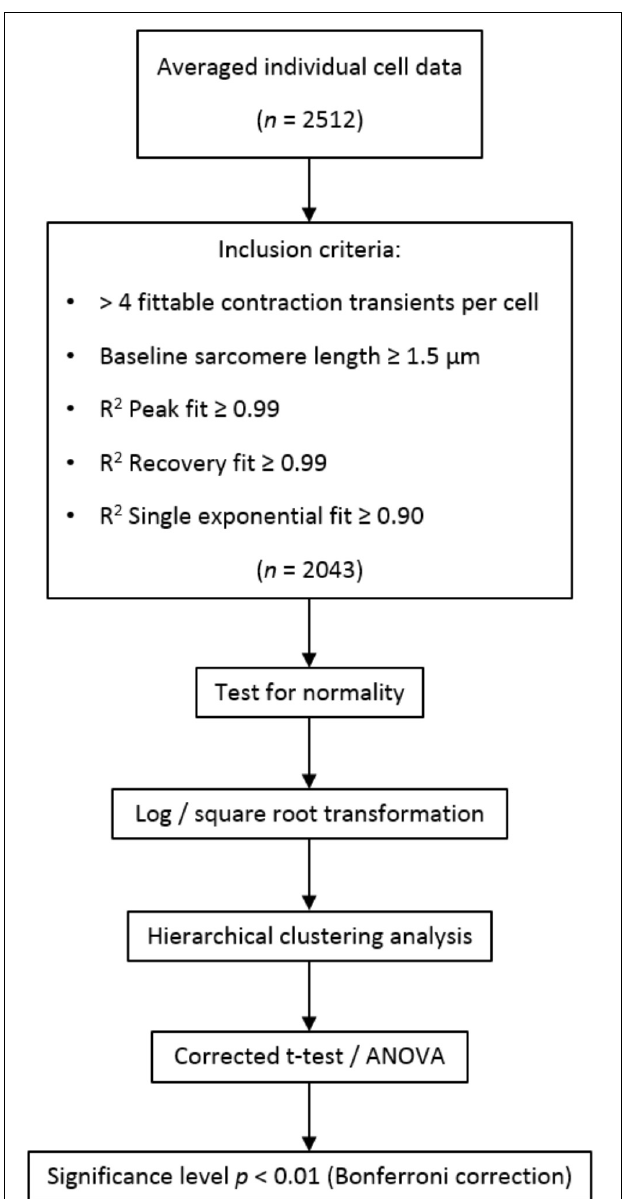
FIGURE 2 | Schematic overview of data processing and analysis. In total, 2,512 cells were measured, of which 2,043 were included in analysis. If no more than four contraction transients could be fitted by the transient analysis software (i.e., due to disturbances in the sarcomere length signal), cells were excluded from the analysis. Short resting sarcomere length and inaccurate fitting of the contraction transients were additional exclusion